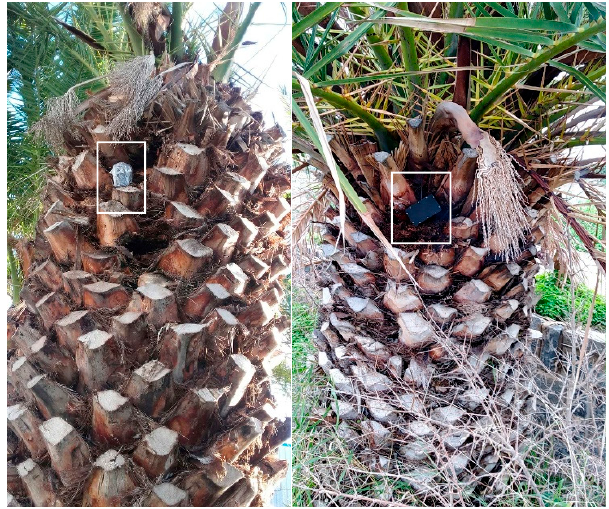
Figure 10. The device attached to a palm tree listening for R. ferrugineus . The white rectangle is located around the device.